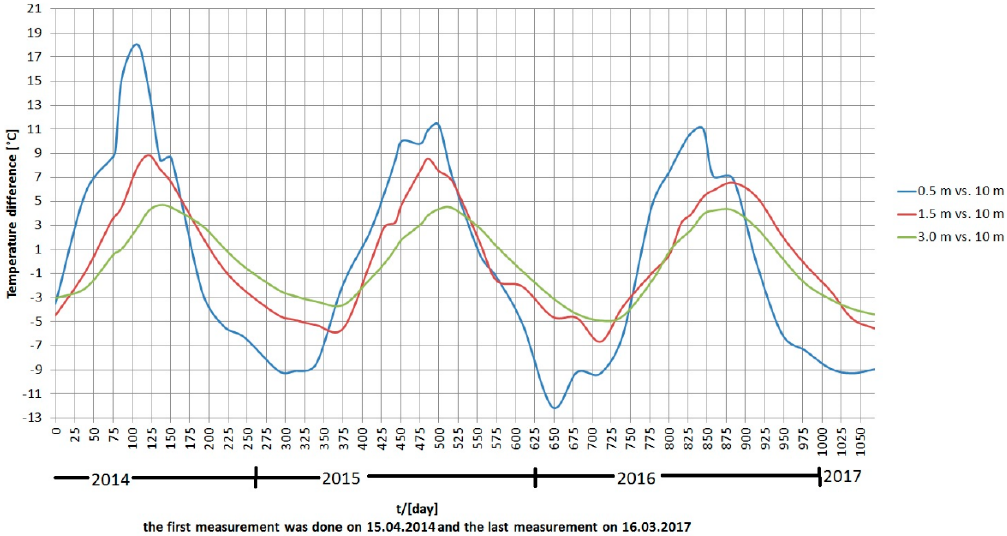
Figure 8. The di ff erence curves compared with each other at 0.5 m, 1.5 m and 3.0 Figure 8. The difference curves compared with each other at 0.5 m, 1.5 m and 3.0 m.